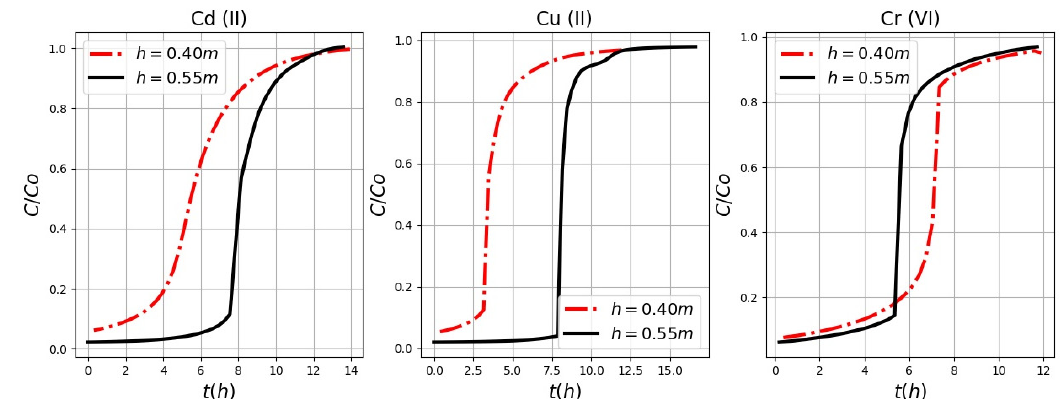
Figure 6. Breaking curves varying height h = 0.40 m (points and line) and h = 0.55 m (solid line) ( a ) Cd (II) with T = 303.15 K and pH = 9.0 ( b ) Cu (II) with T = 303.15 K and pH = 9.0 and ( c ) Cr (VI) with T = 303.15 K and pH = 4.0. Table 9. t (cid:2912) varying height for Cd (II), Cu (II) and Cr (VI).